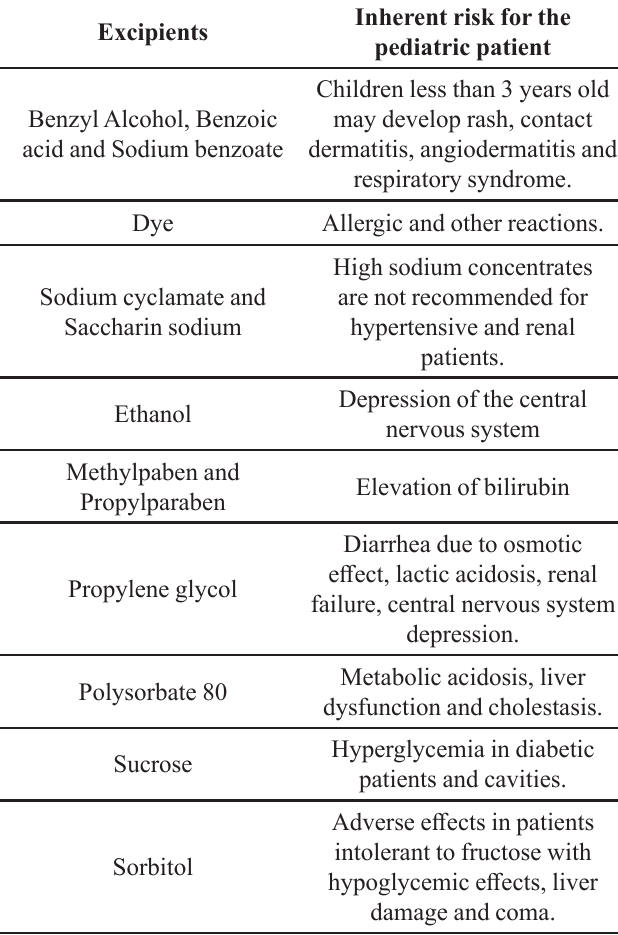
TABLE I - Some excipients, when administered to pediatric patients, may cause health risk (WHO, 2011a; Cuzzolin,